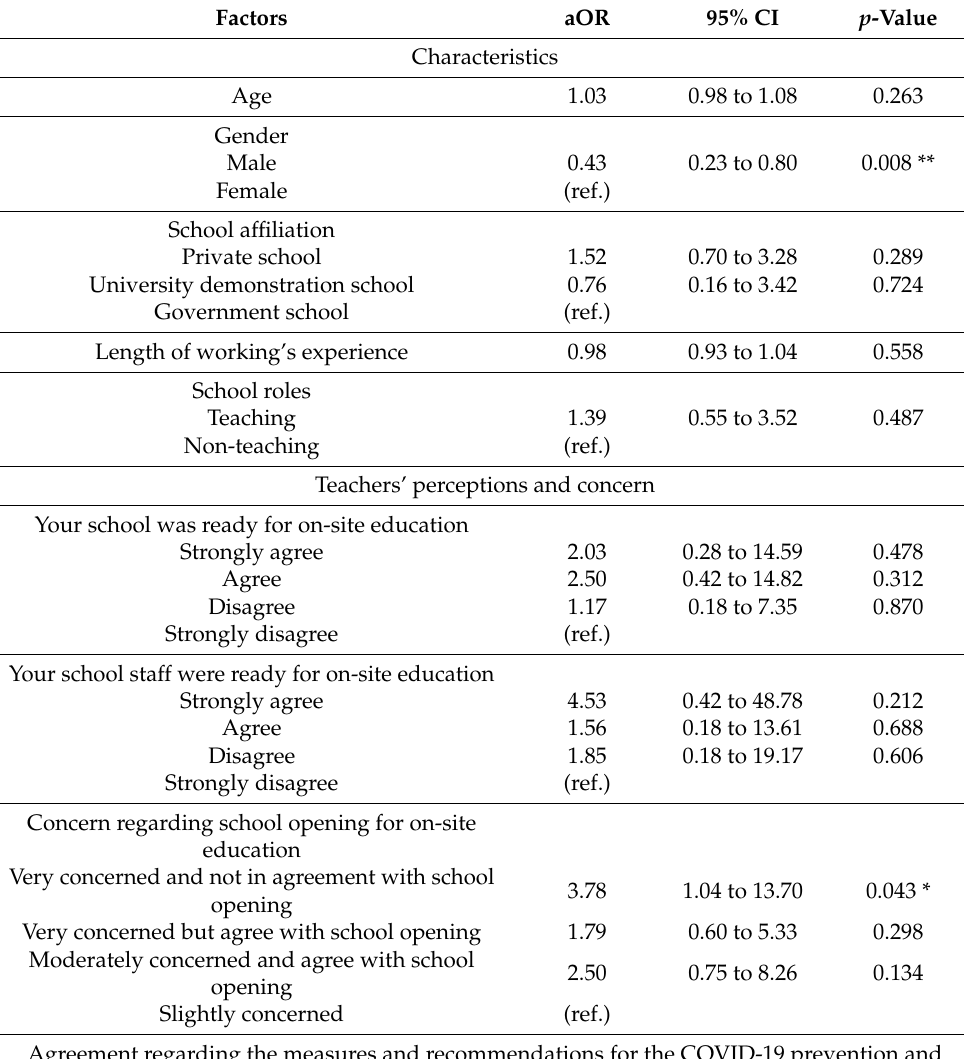
Table 4. Factors affecting the participant’s consistently performing the measures and recommenda- tions for COVID-19 prevention and control in schools. Factors aOR 95% CI p -Value Characteristics